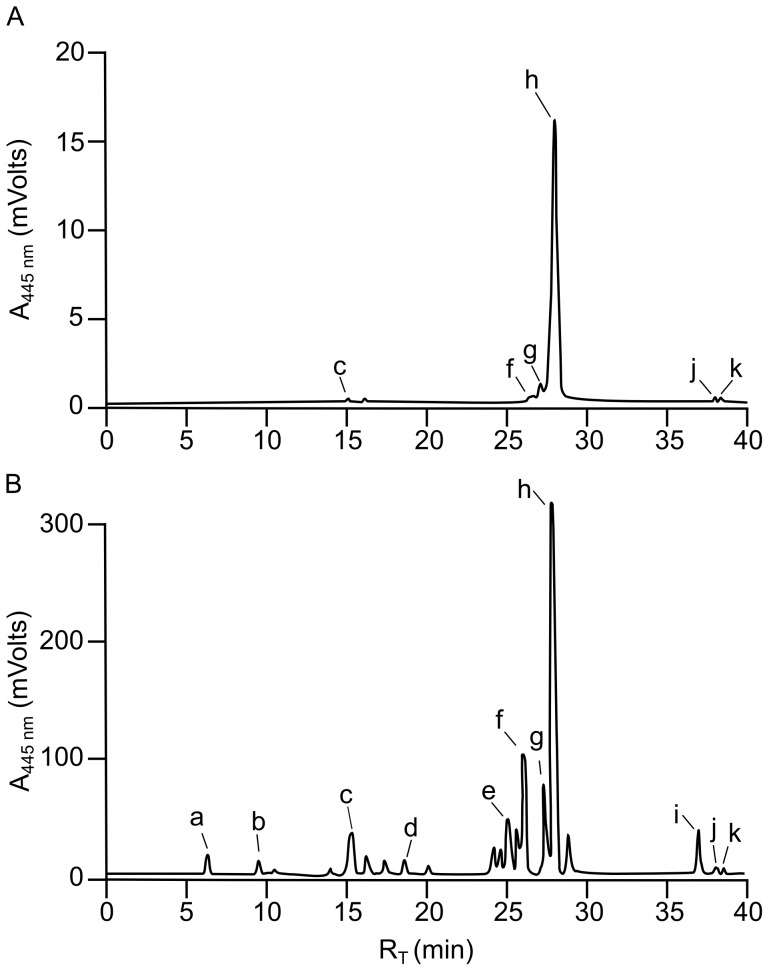
RP-HPLC of carotenoids extracted from EBP and from E. chloroticus gonad tissue.Carotenoids extracted from native-PAGE eluate (Figure 1) A and from lyophilized whole gonad tissue B, were separated by RP-HPLC. Each carotenoid extraction corresponded to a whole gonad, of the same weight, taken from a single animal. For RP-HPLC analysis a 100 µL aliquot of carotenoid was injected onto a C30 RP-HPLC and carotenoids were eluted with a methanol/TBME gradient. Column effluent was monitored at 445 nm and carotenoids were identified by comparison of retention times (RT) to commercial standards. The carotenoids identified were a. fucoxanthinol, b. fucoxanthin, c. astaxanthin, d. canthaxanthin, e. lutein, f. isozeaxanthin, g. all-trans-echinenone, h. 9′-cis-echinenone, i. α-carotene, j. all-trans-β-carotene and k. 9′-cis-β-carotene.